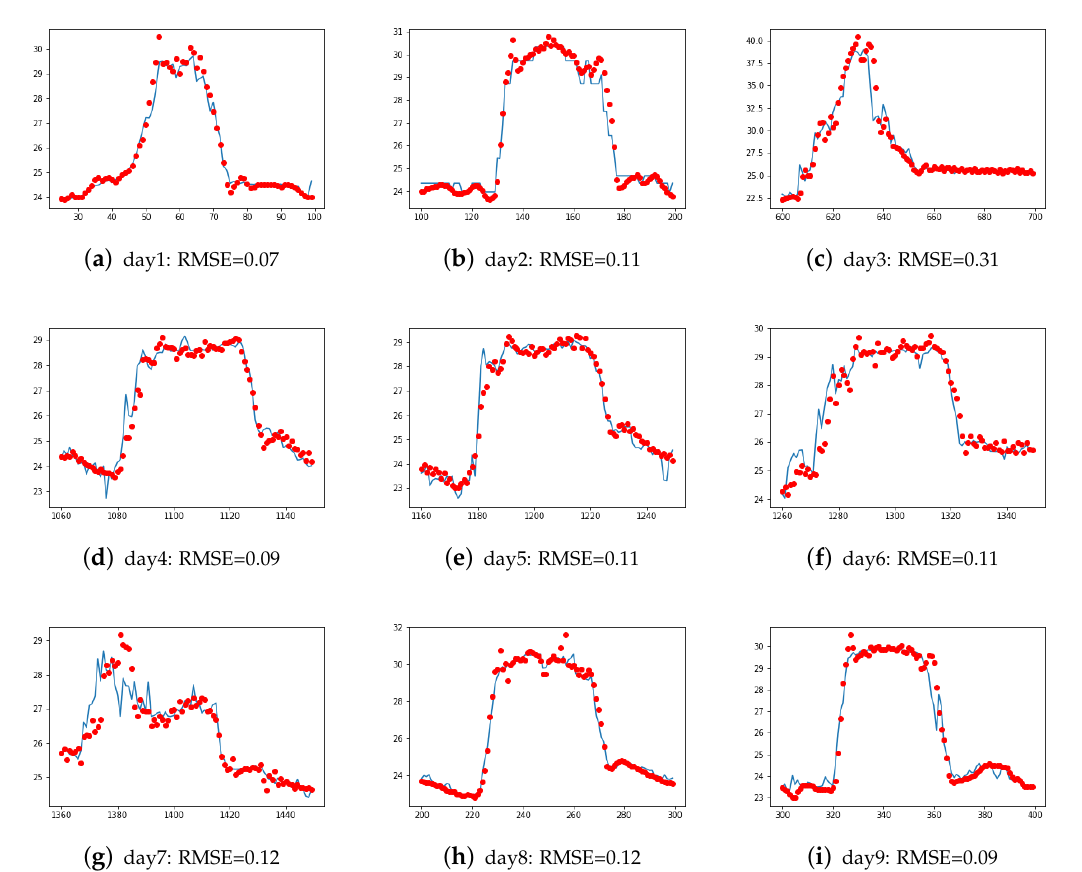
Figure 6. Predicted temperature (dots) versus measured temperature (lines) and root-mean-square error